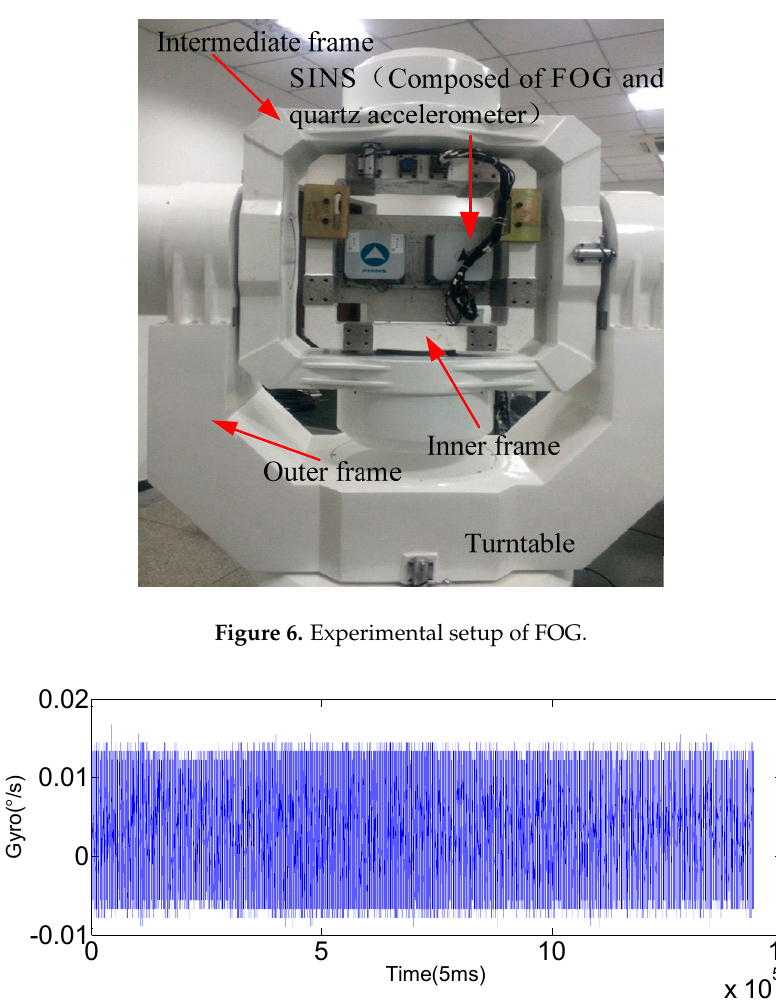
Figure 7. Raw output of the gyroscope ( x -axis).